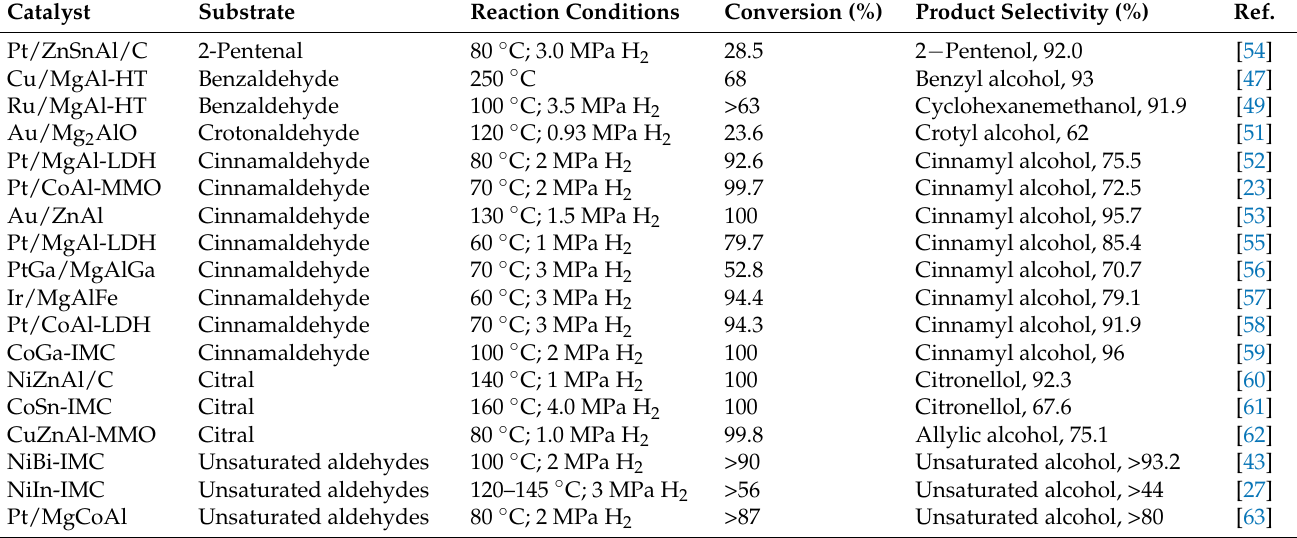
Table 2. Catalytic performances of LDH-derived catalysts for hydrogenation of ketones and